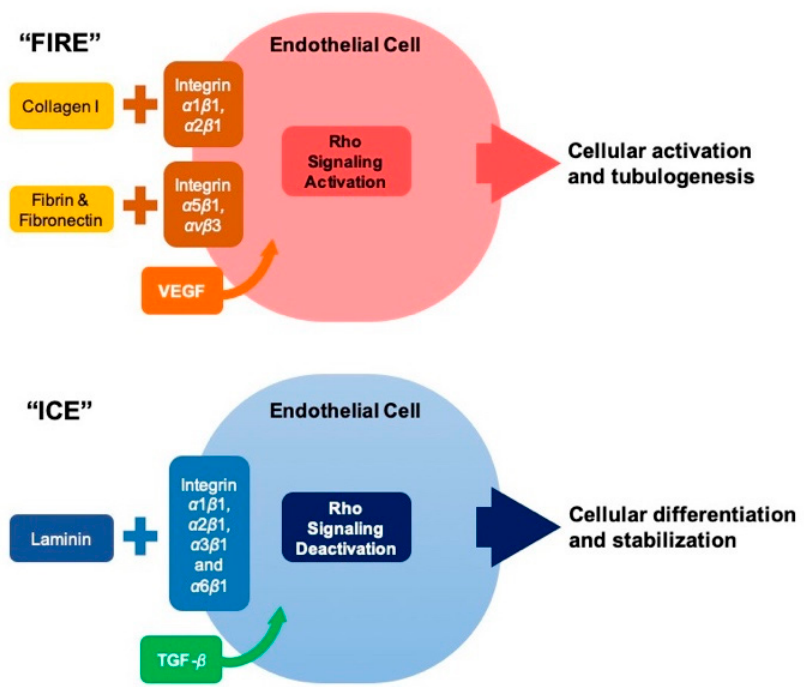
Figure 8. Extracellular matrix mediated endothelial morphogenesis. The diagram illustrates the concept of “fire and ice” representing balance of extracellular matrix-based signaling which dictates endothelial cellular activation and tubulogenesis with endothelial cell stabilization. The complex process is mediated by the interaction between extracellular matrix components (including collagen I, fibrin, fibronectin and laminin) and various integrins. Abbreviations: VEGF: vascular endothelial growth factor; TGF- β : transforming growth factor beta.